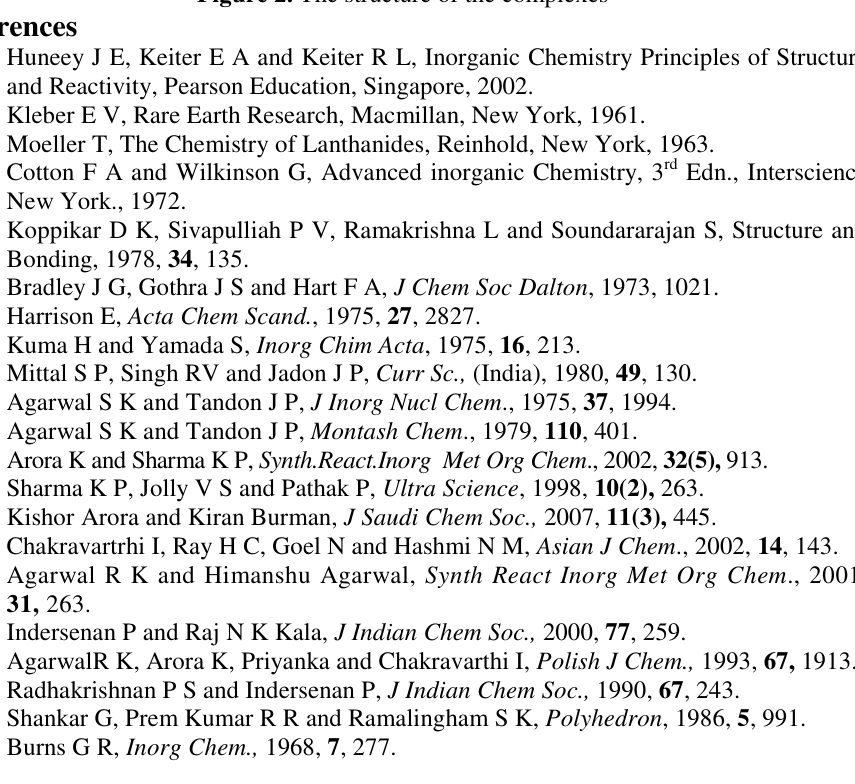
Figure 2. The structure of the